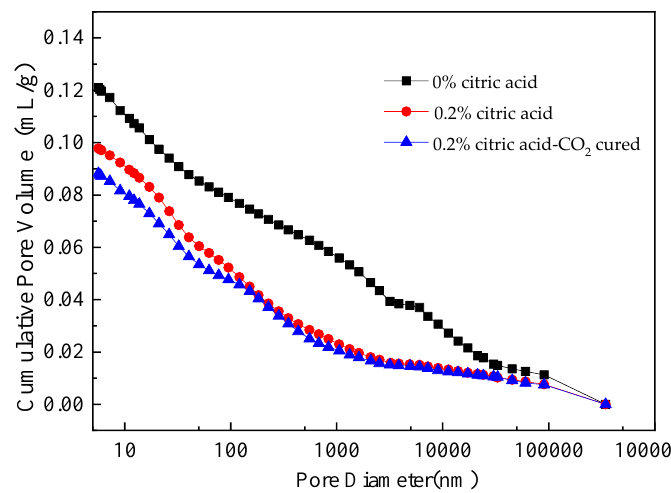
Figure 14. Relationship between pore size and mercury intake. Table 3. The density of MOS (g/cm 3 ). Table 3. The density of MOS (g/cm 3 ). With 0% Citric Acid With 0.2% Citric Acid With 0.2% Citric Acid-CO 2 With 0% Citric Acid With 0.2% Citric Acid With 0.2% Citric Acid-CO 2 Cured